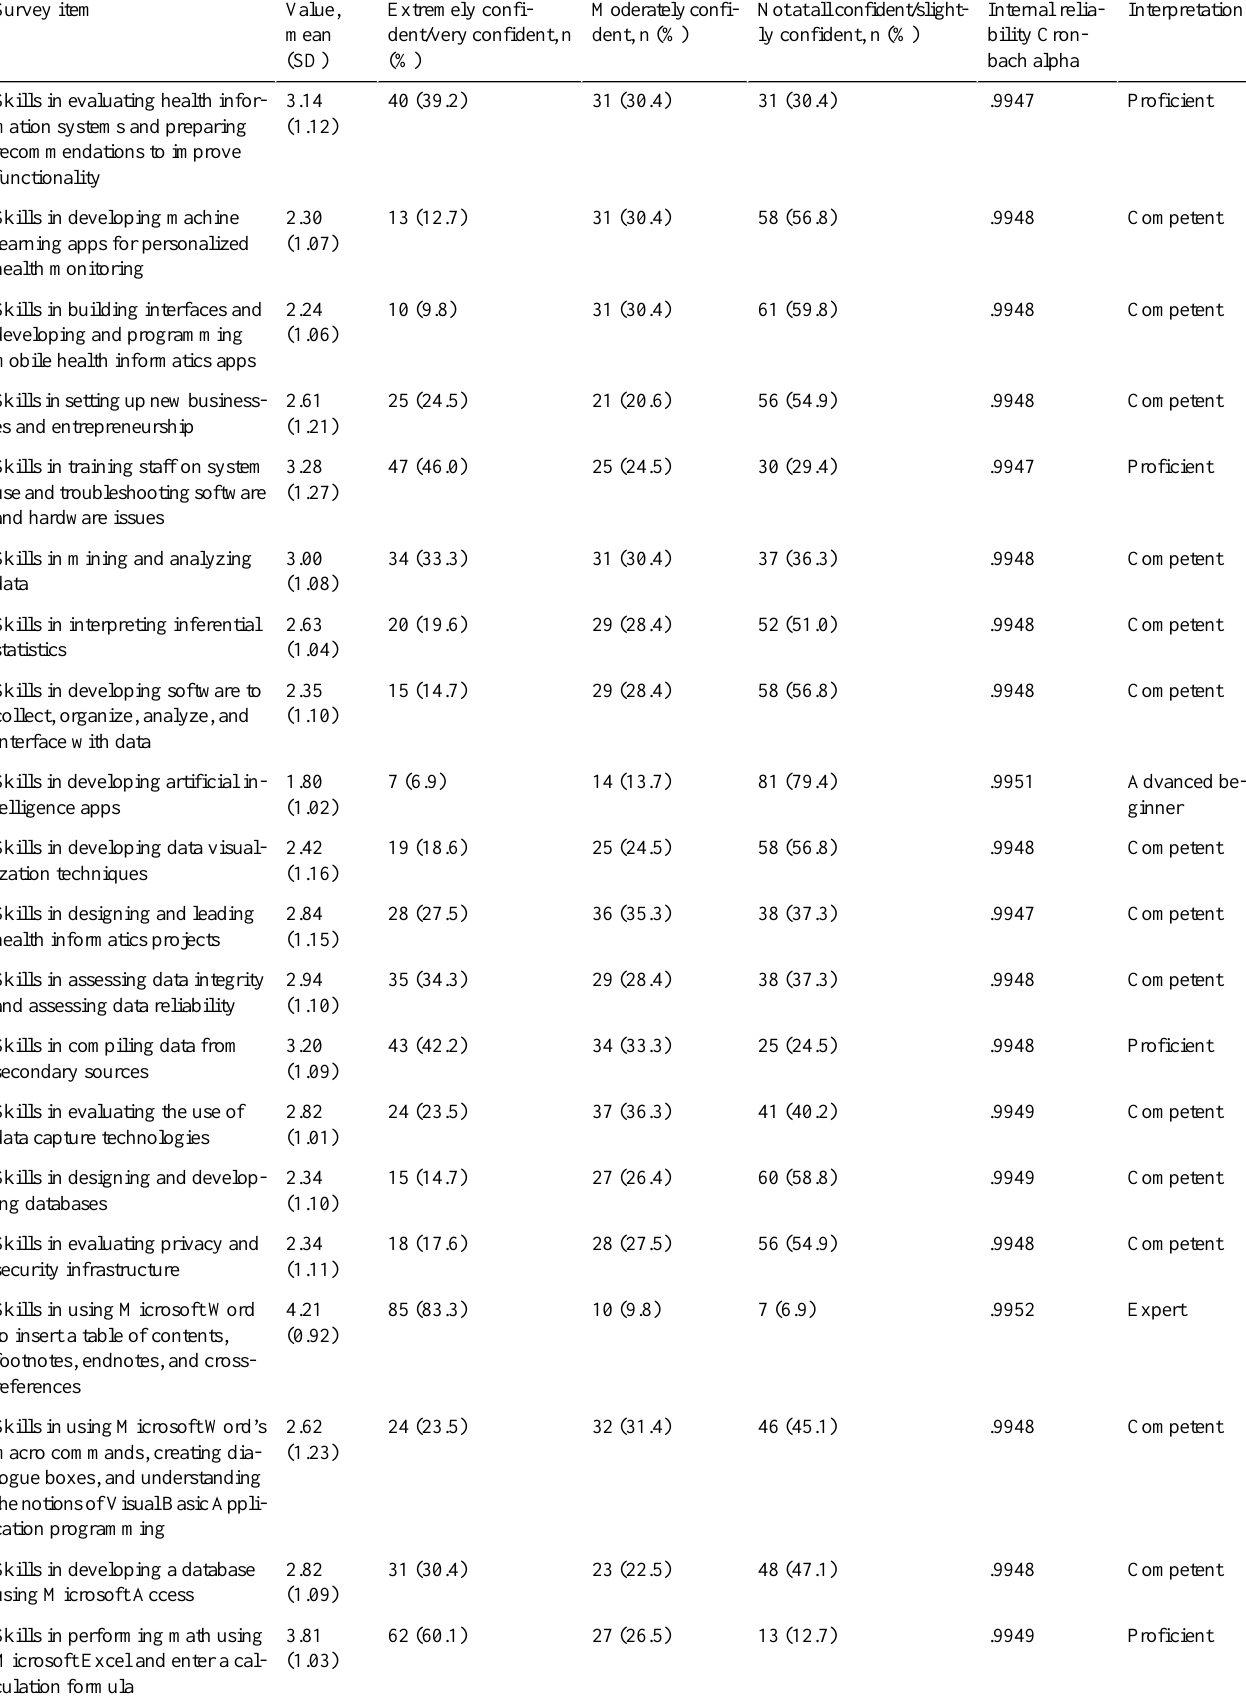
Table 4. Students’ responses regarding confidence with specific health informatics skills (N=102) (competency level according to Benner’s 5 levels of competencies: 0:00-1:00=novice; 1:0-2:00=advanced beginner; 2:0-3:00=competent; 3:01-4:00=proficient;